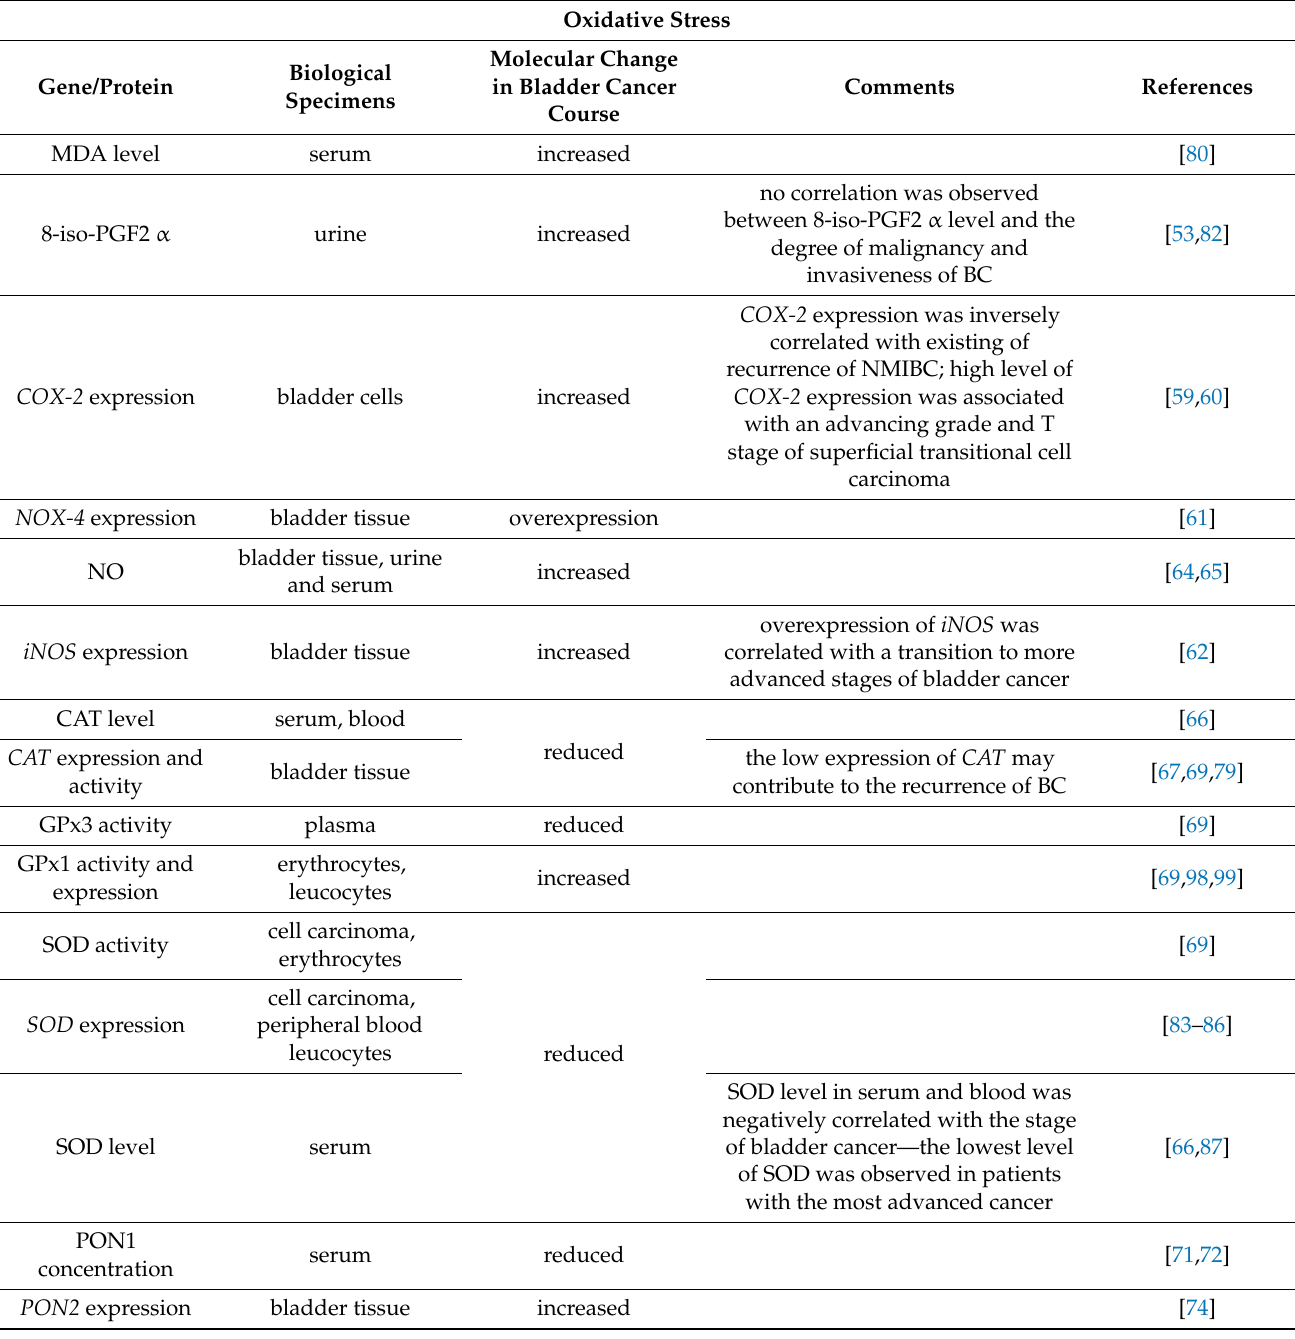
Table 3. Potential biomarkers of bladder cancer